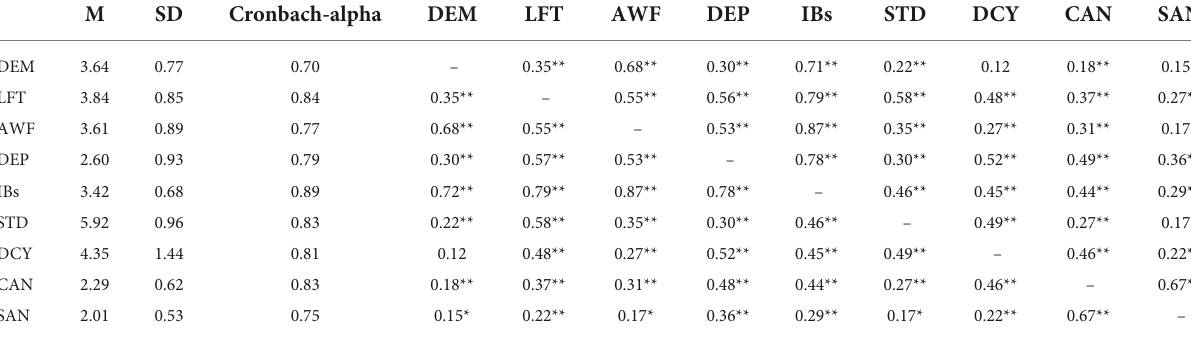
TABLE 1 Descriptive statistics, reliability, and correlation of variables (iPBI, SAPS, and CSAI-2-H). M SD